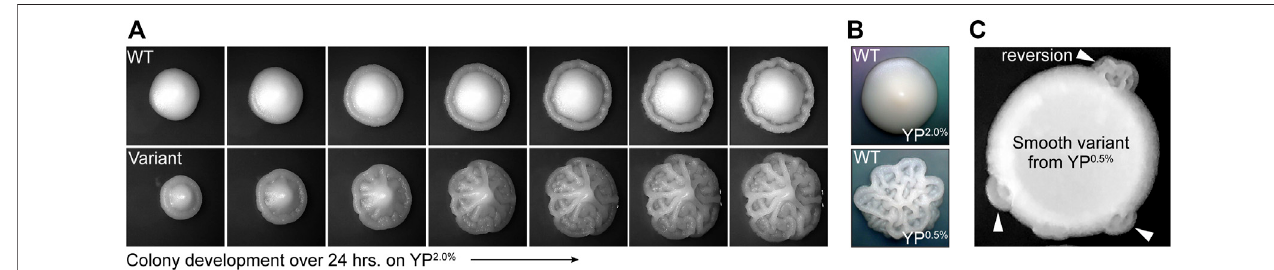
FIGURE 1 | Phenotypic variants spontaneously arise in populations of YJM311. (A). Representative time-course images of 2-day old WT colony and complex variantcolonydevelopingover24 honYP 2.0% . (B) .RepresentativeimagesofWTYJM311colonymorphologiesonYP 2.0% (top)YP 0.5% (bottom). (C) .Animagedepicting a cell spot of a smooth variant (6 sv ) isolated from YP 0.5% ; the smooth variant phenotype persists throughout the spot, but regions denoted by white arrowheads have reverted to the WT morphology ( i.e.,